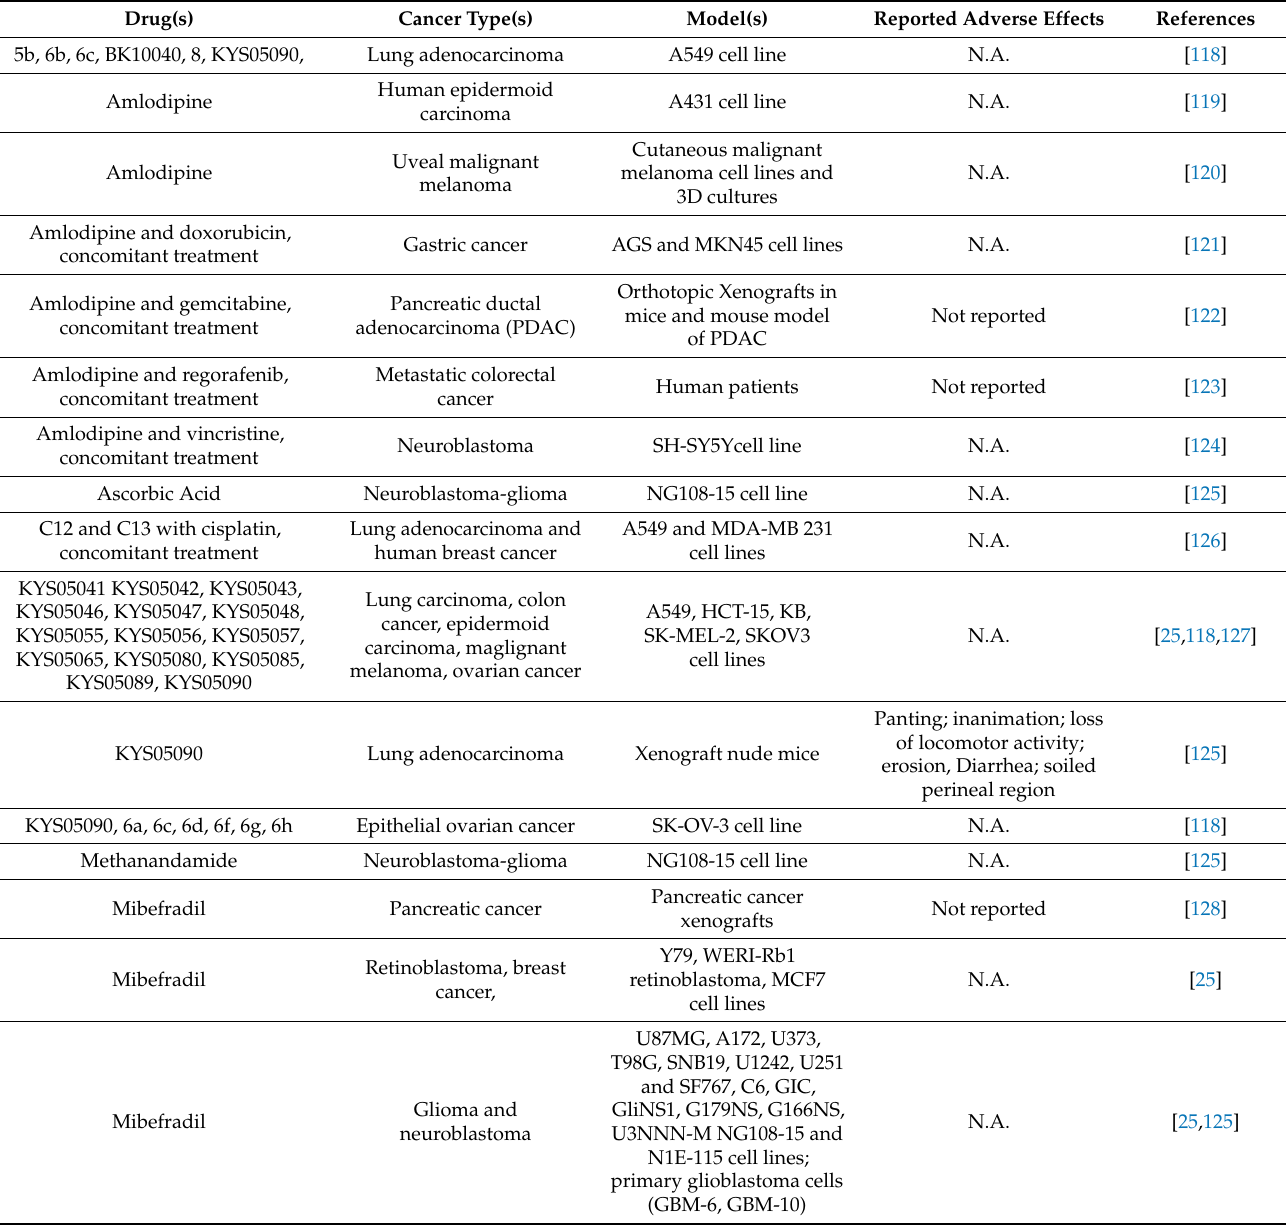
Table 2. Known compounds targeting T-type calcium channels studied in pre-clinical research or in clinical